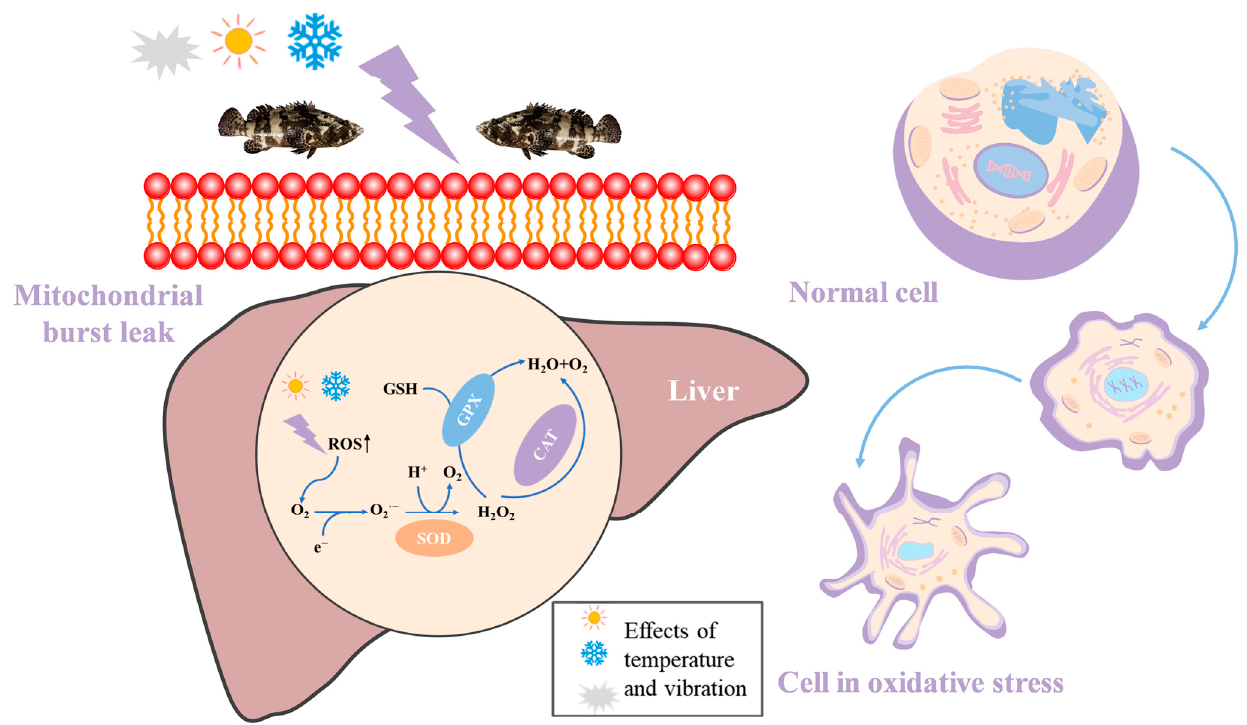
Figure 9. The groupers were subjected to temperature and vibration stress, and large amounts of reactive oxygen species were produced in the organisms. The antioxidant enzymes SOD, CAT, and GSH-PX were increased to eliminate the production of reactive oxygen species. Normal cells began to experience apoptosis.